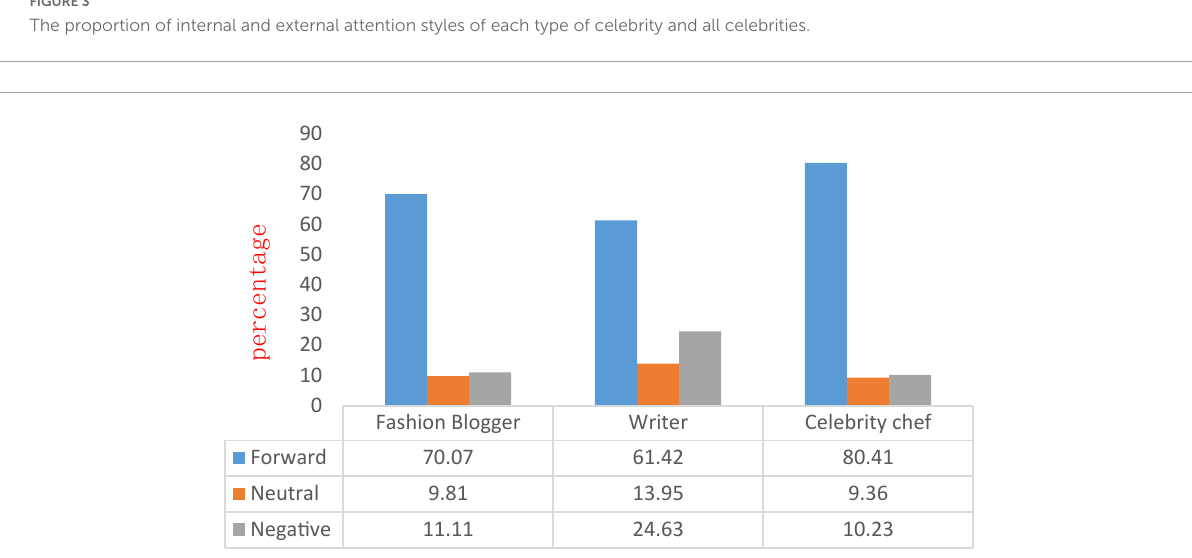
FIGURE4 The emotional style ratio of each category of celebrities and all celebrities.